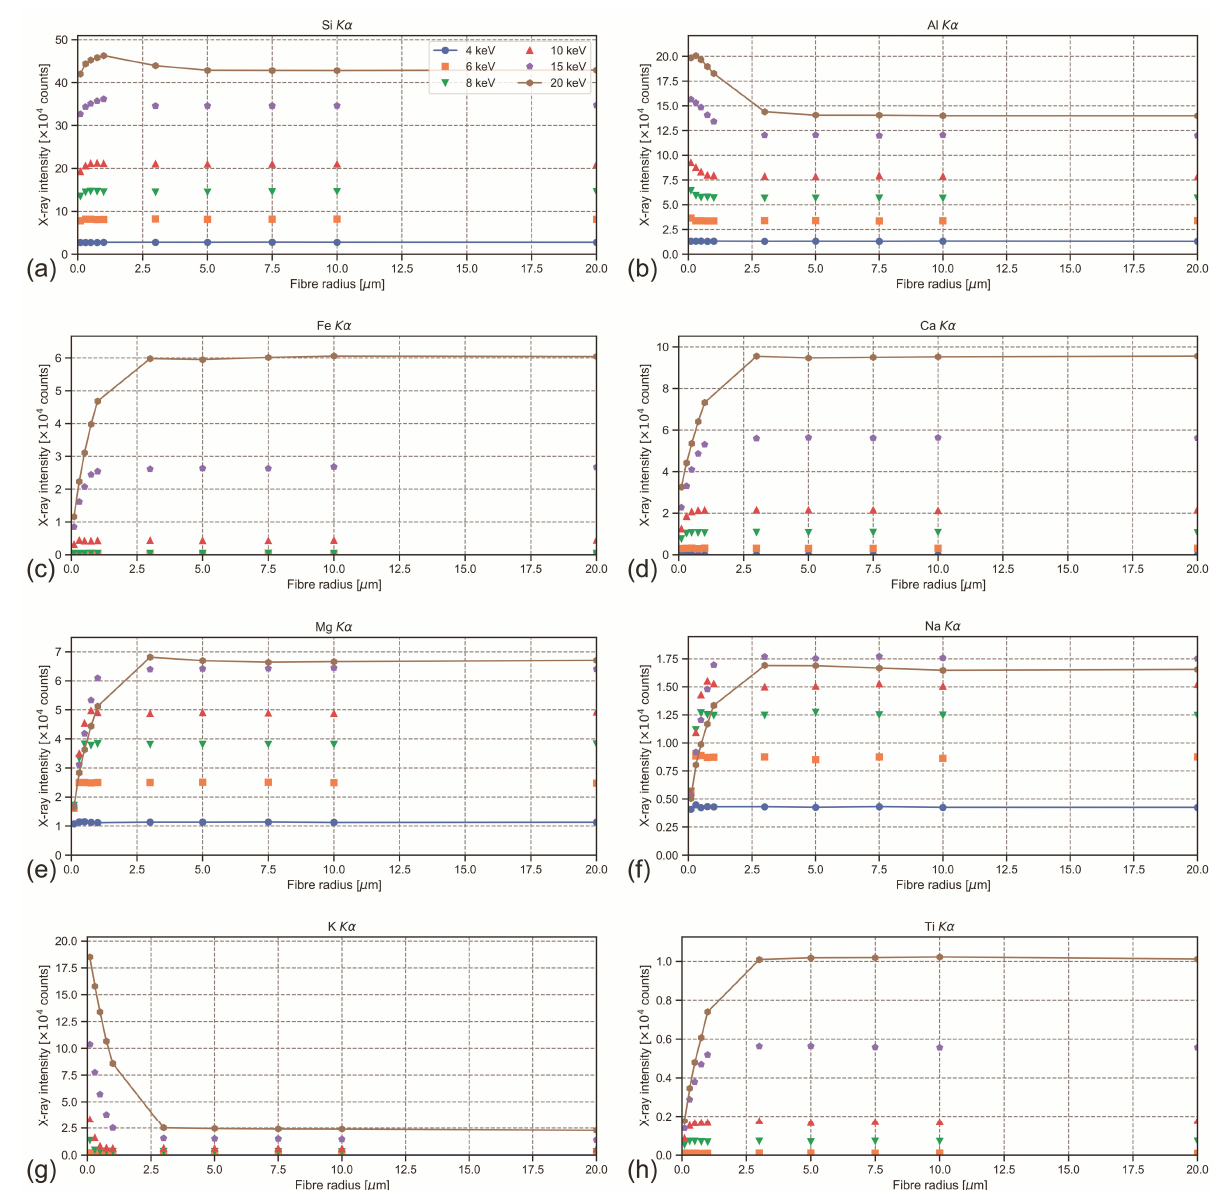
Figure A1. Simulated SEM-EDS integrated X-ray intensities of ( a ) Si, ( b ) Al, ( c ) Fe, ( d ) Ca, ( e ) Mg, ( f ) Na, ( g ) K and ( h ) Ti K α lines, plotted as a function of the fibre radius, for selected electron beam energies and with the analytical point on the centre of the circular section of the fibre.